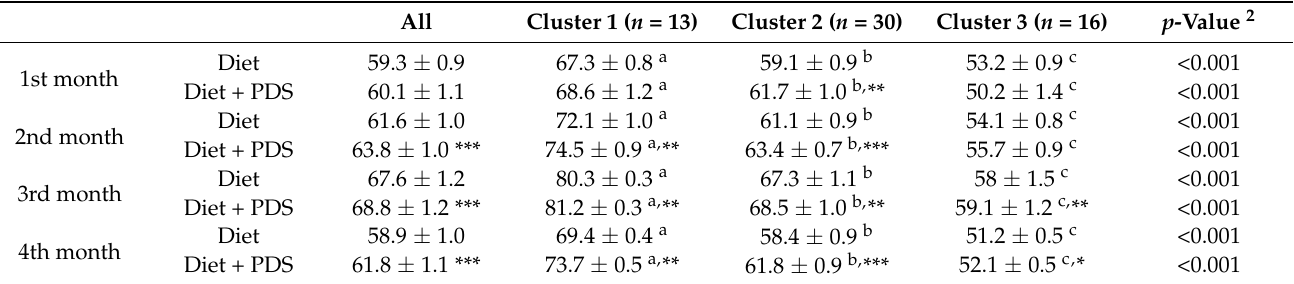
Abbreviations: PDS, plant-based dietary supplements; T-HEI, Taiwanese Healthy Eating Index. 1 Values expressed as mean ± standard error of mean. 2 Based on Kruskal Wallis test with Bonferroni’s correction; a,b,c Nonidentical superscript indicated significant difference. *, **, *** Indicated significant different from diet alone, compared by